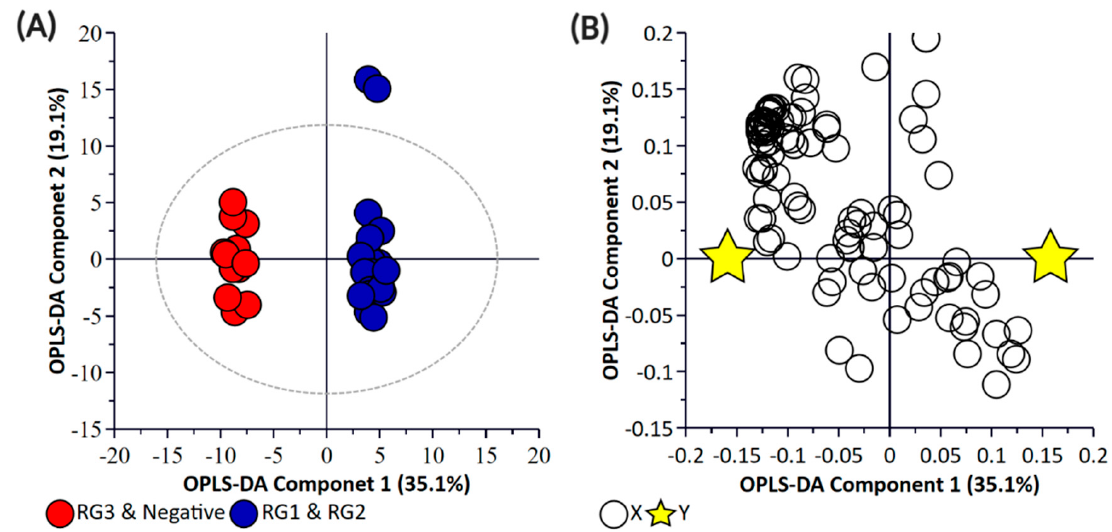
Figure 2. Orthogonal Partial Least Square-Discriminant Analysis ( A ) scatter plot and ( B ) loading plot of bacterial pellet samples collected from BPW cultures ( n = 36; note, the negative group includes Salmonella). R 2 X (cum) = 0.698, R 2 Y (cum) = 0.989, Q 2 = 0.879. Note, the ellipse presented in Figure 2A represents Hotelling’s T 2 confidence limit (95%). Note: The colored circles in panel “A” represent each analyzed sample, while the yellow-colored stars in panel “B” indicate the average group position for each sample cluster, with the white circles representing the distribution of metabolite features between these groups.